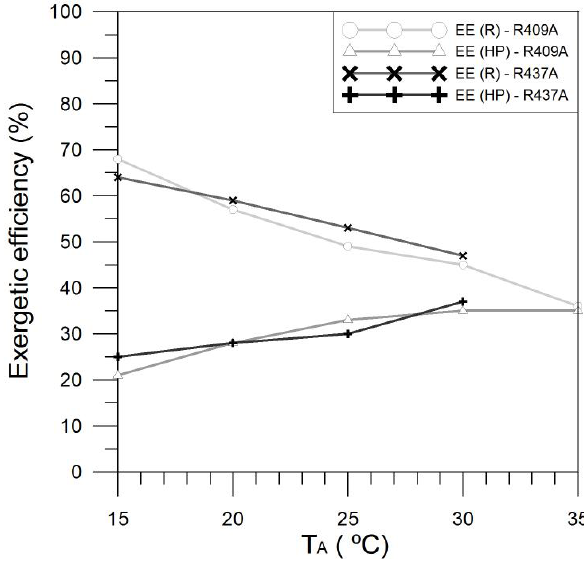
Figure 12: Effect of the heat source temperature on η (Group A of tests).